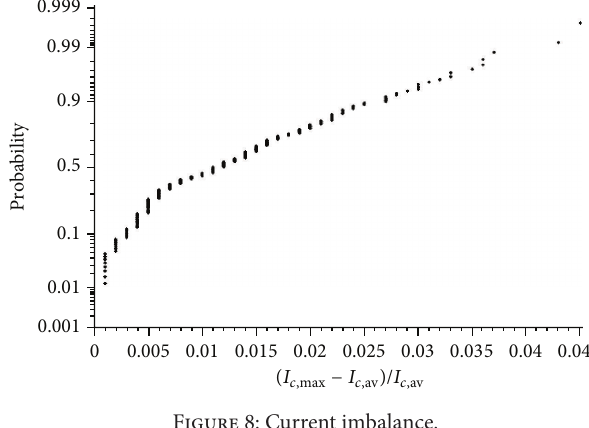
Figure 8: Current imbalance.